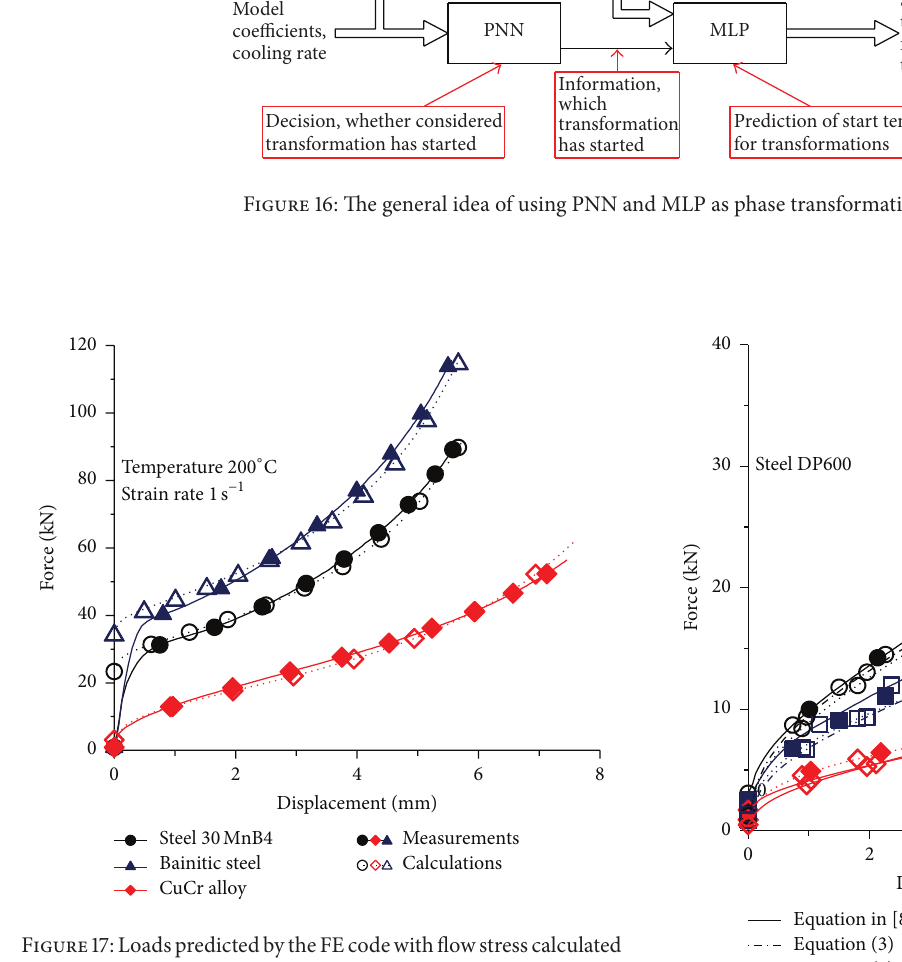
Figure17:LoadspredictedbytheFEcodewithflowstresscalculated from (1) with coefficients determined using inverse analysis with metamodelcomparedwiththemeasurementsfortheCuCralloyand for the two steels.